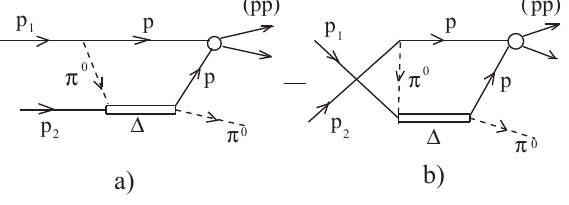
Figure 1. The Δ -isobar mechanism of the reaction pp → { pp } s π 0 with the direct (a) and exchange (b)